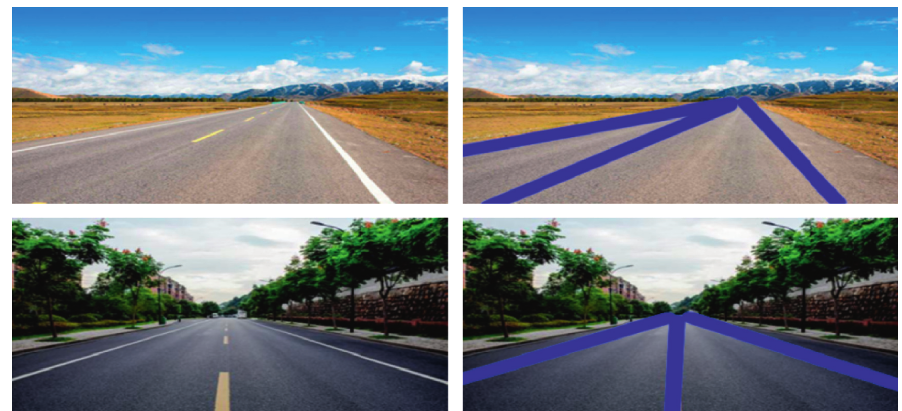
Figure 5: Different lane marking results.